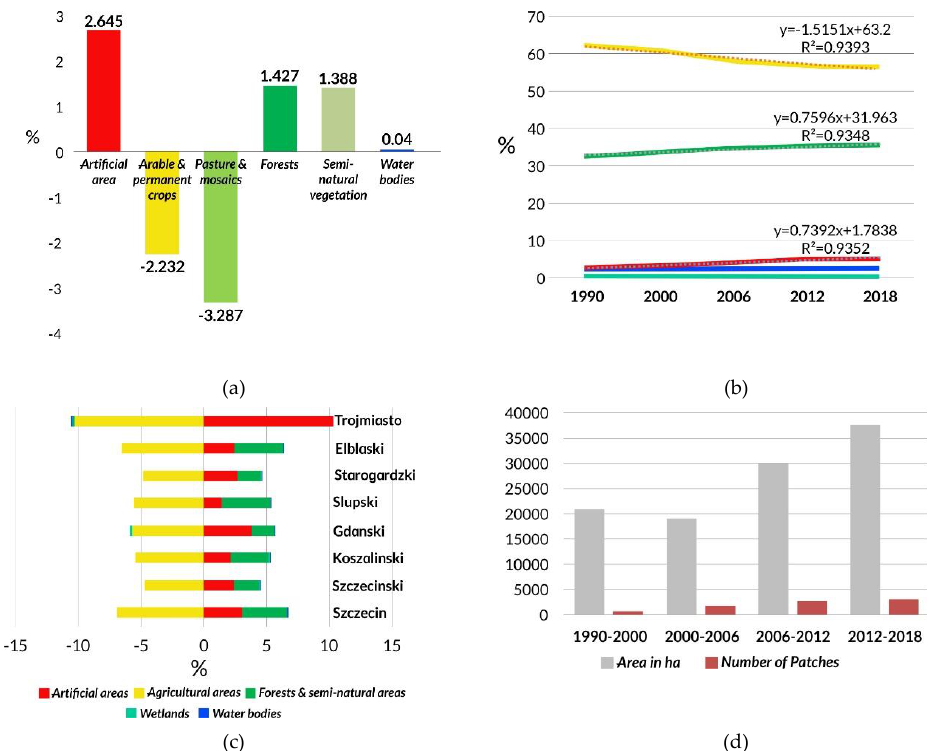
Figure 4. Land cover changes in the Polish Baltic coastal region: ( a ) net changes in percent 1990-2018; ( b ) percent of main CLC land cover types; ( c ) net changes in percent 1990-2018 by regions; ( d ) total area and number of patches.